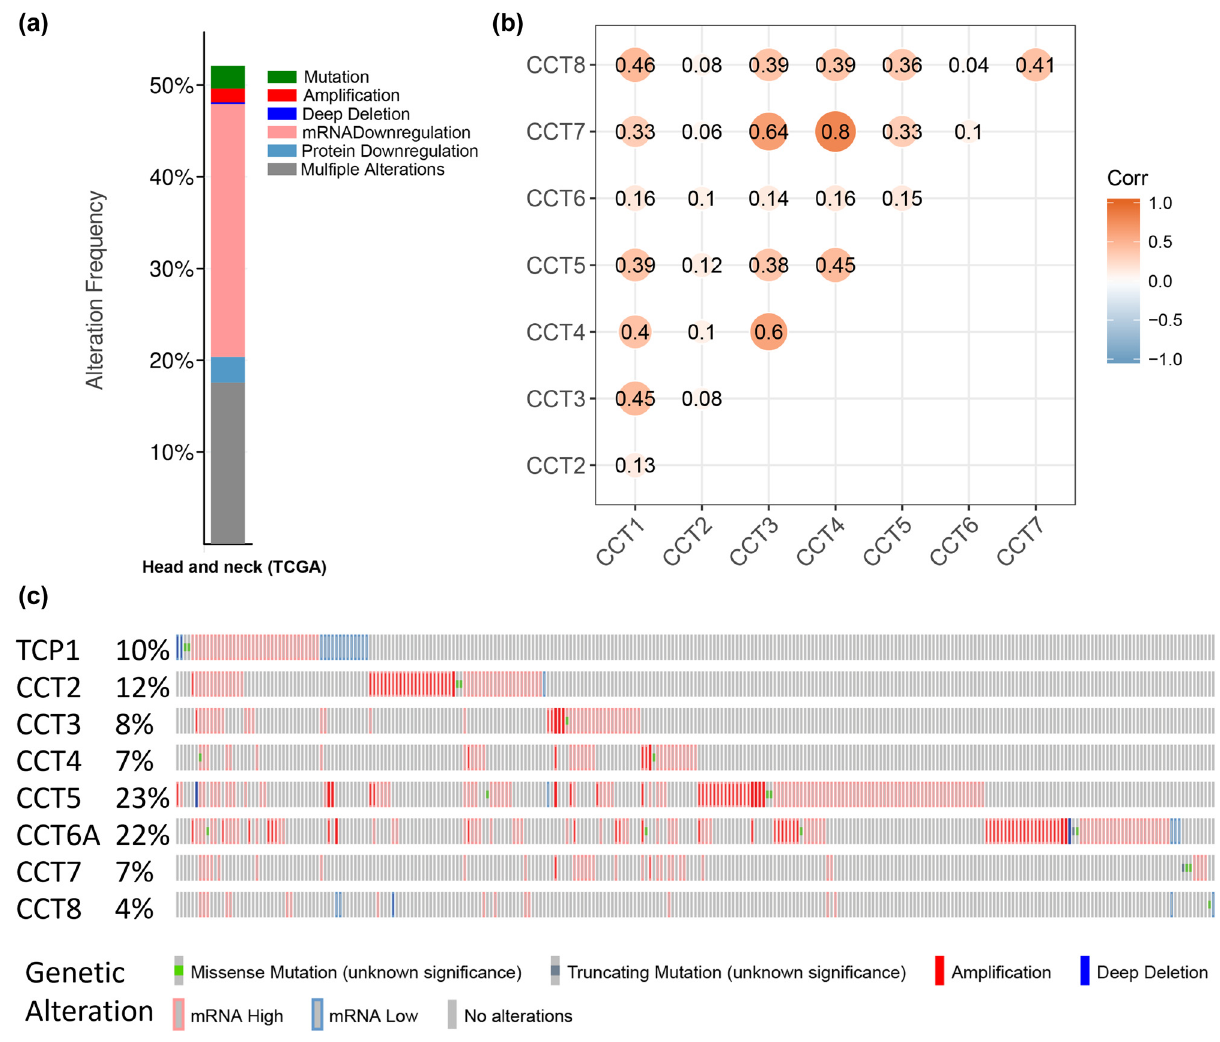
Figure 7: Genetic expression and alteration analysis associated with CCTs in TCGA HNSC ( cBioPortal ) . ( a ) The total alteration frequency of eight CCT genes in TCGA HNSC is illustrated. ( b ) Co - expression heatmap of CCT genes in TCGA HNSC, visualized by the R environment. ( c ) Oncoprint in the cBioPortal represented the proportion and distribution of samples with alterations in